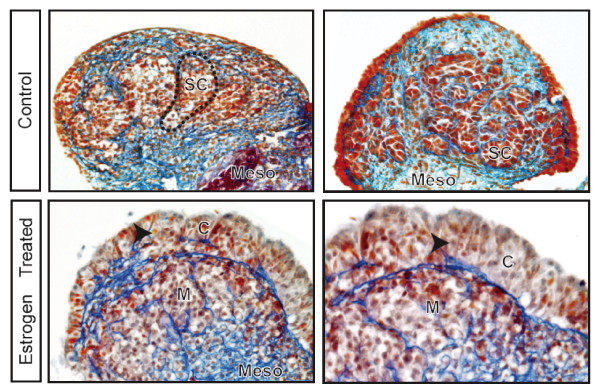
Structure of control and oestrogen-cultured gonads. Oestrogen-cultured XY gonads developed ovarian-like cortical and medullary structures with germ cells distributed at the periphery of the cortex (arrowhead), while control gonads developed normal testicular architecture with germ cells confined to testis cords. Gonad plus mesonephros (meso)complexes were sectioned at 8 μm and stained with Mallory's triple stain. Top: Gonads cultured in control media. Bottom: Gonads cultured in the presence of oestrogen. Control XY gonads have normal male development with the formation of seminiferous cords (SC; outlined by dashed line) delineated by a basal lamina (stained dense blue) with the germ cells contained within these structures. Oestrogen-treated XY gonads formed a cortex (C) which contained germ cells and a central medulla (M), resembling the normal ovarian architecture of equivalent stage XX gonads.